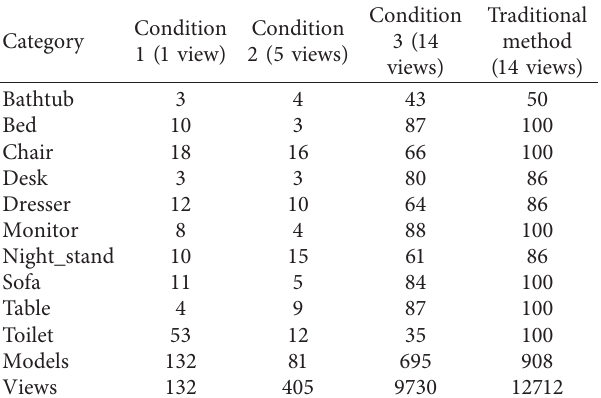
Table 10: The model numbers under different